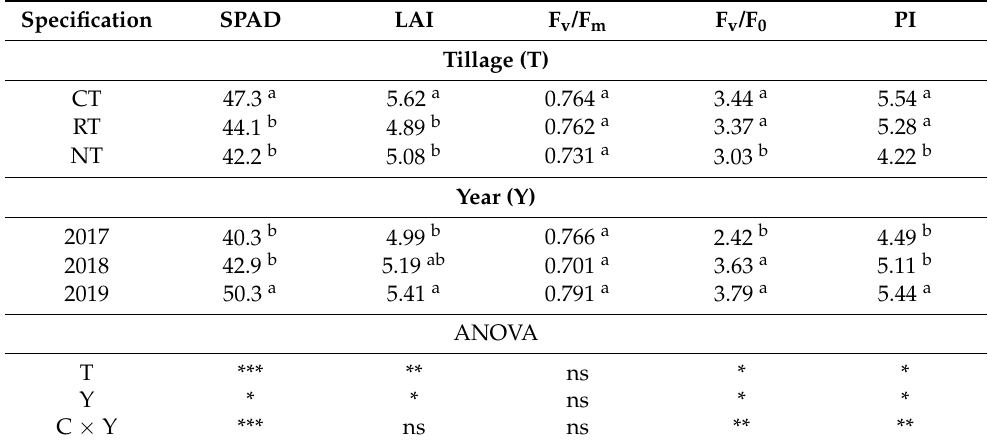
Table 3. Soil plant analysis development (SPAD), leaf area index (LAI), and chlorophyll fluorescence. Specification